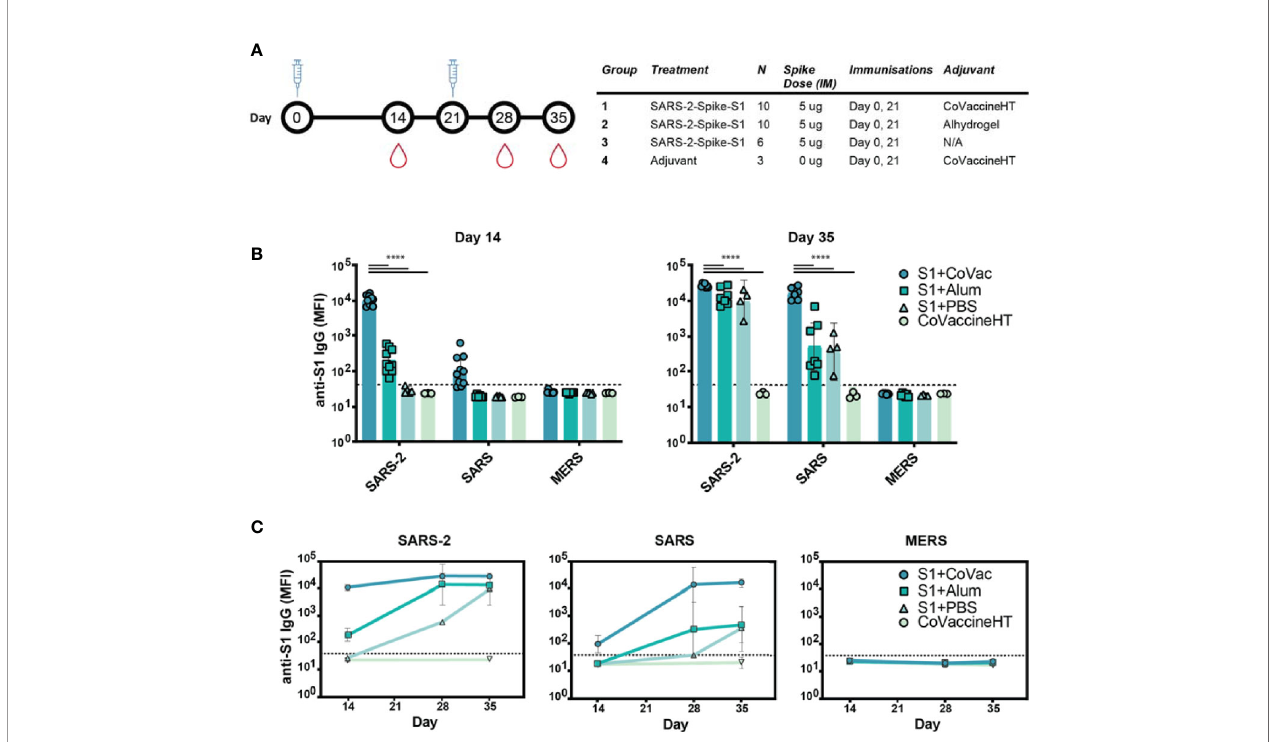
FIGURE 1 | Immunogenicity and speci fi city to SARS-CoV-2 S1 immunization. (A) Timeline schematic of BALB/c immunizations and bleeds with a table detailing the study design. (B) Median fl uorescence intensity (MFI) of serum antibodies from each group binding to custom magnetic beads coupled with Spike S1 proteins from either SARS-CoV-2 (SARS-2), SARS-CoV (SARS), or MERS-CoV (MERS) on day 14 and 35. (C) Antibody reactivity to SARS-2, SARS, and MERS antigens throughout the study. Graphs in (B, C) are on a logarithmic scale representing geometric mean MFI responses with 95% con fi dence interval (CI). The dashed lines represent assay cut-off values determined by the mean plus three standard deviations of the negative control (BSA coupled beads). Statistics by standard two-way ANOVA. ****p-value <